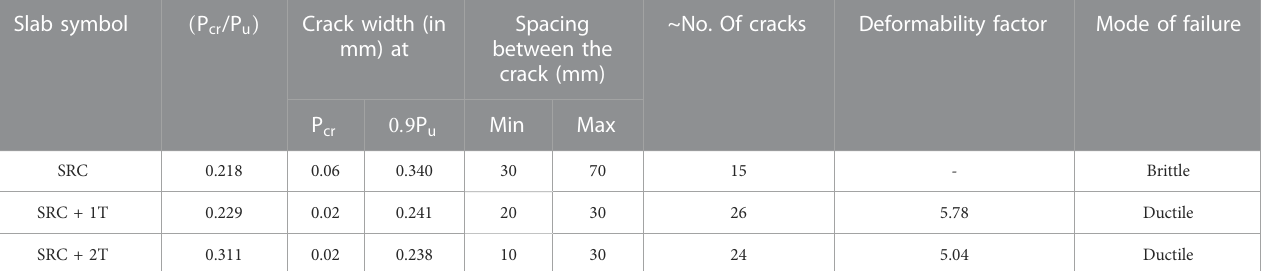
TABLE 2 Details of the crack pattern and failure mode. Slab symbol ( P cr /P u ) Crack width (in